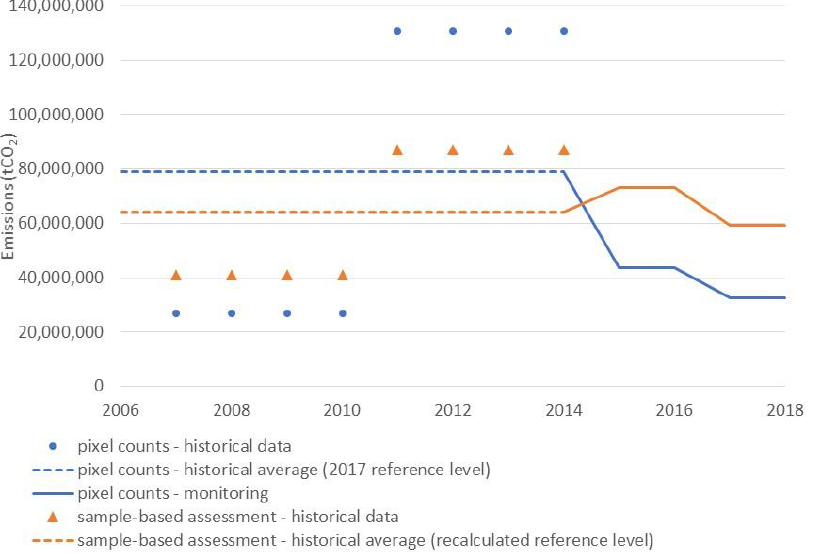
Figure 2. Cambodia’s emission estimates based on pixel count and sample-based activity data generated from data in Cambodia’s technical annex to its Biennial Update Report (BUR) submitted to the UNFCCC in 2020 [48].